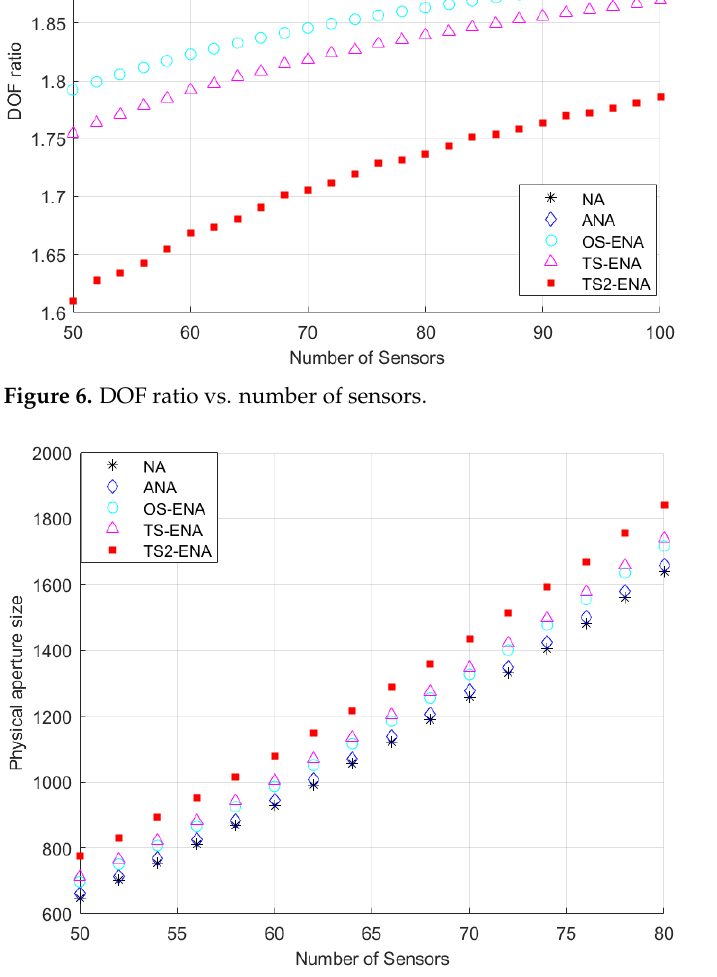
Figure 7. Physical aperture vs. number of